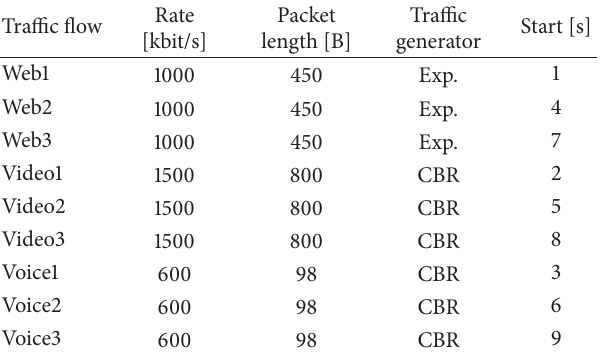
Table 2: Traffic